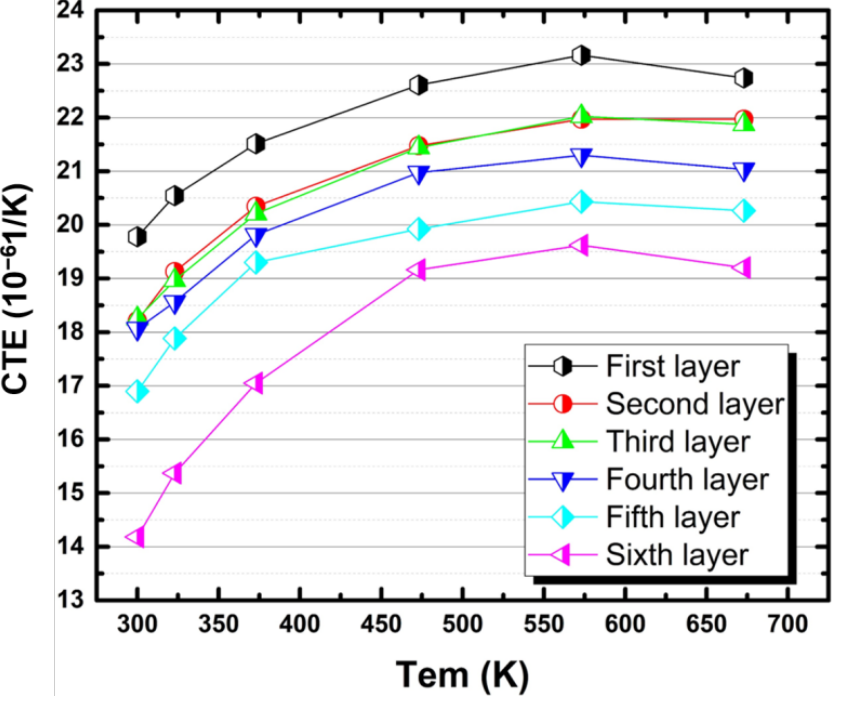
Figure 7. The CTE of different layers in terms of height of the bimetallic gradient composite alloy.